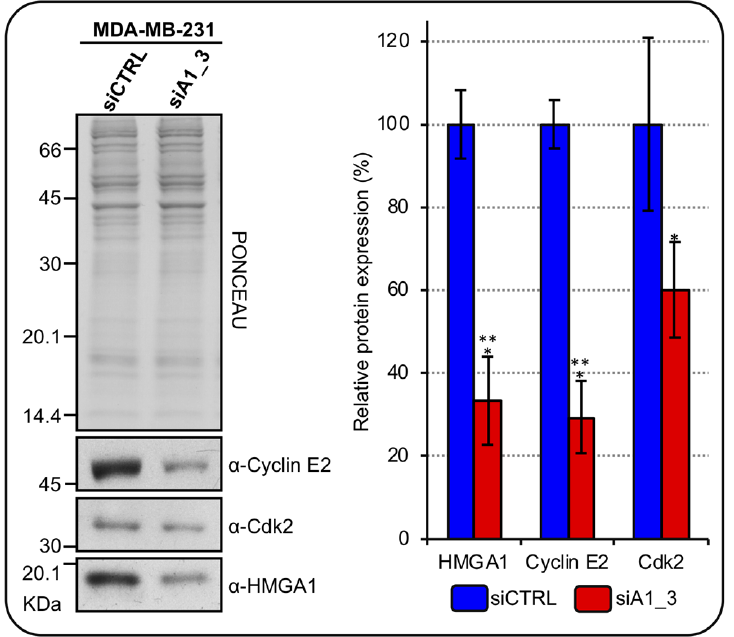
Figure 5. HMGA1 regulates cyclin E2 and Cdk2 expressions in MDA-MB-231 cells. Western blot analyses assess cyclinE2 and Cdk2 protein expression in MDA–MB–231 cells silenced for HMGA1 (siA1_3) or treated with control siRNA (siCTRL). Representative WB analyses, on the left, are shown together with red ponceau stained membrane to verify total protein normalization. The histogram graph on the right refers to densitometric analysis of western blot (siCTRL and siA1_3). Bars indicate the mean. Standard deviations are shown ( n = 3). Statistical significance was assessed with Student’s t-test (*: p ≤ 0.05; ***: p ≤ 0.001).